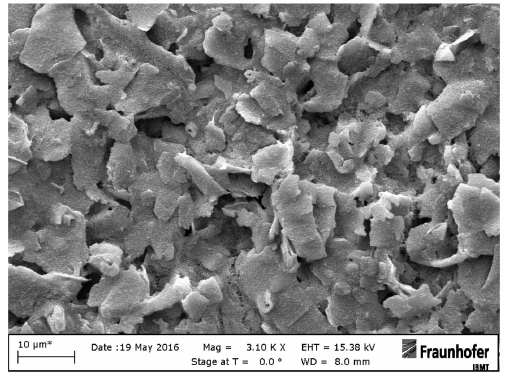
Figure 2. SEM image of a printed graphene electrode F with 20 µ m resolution.